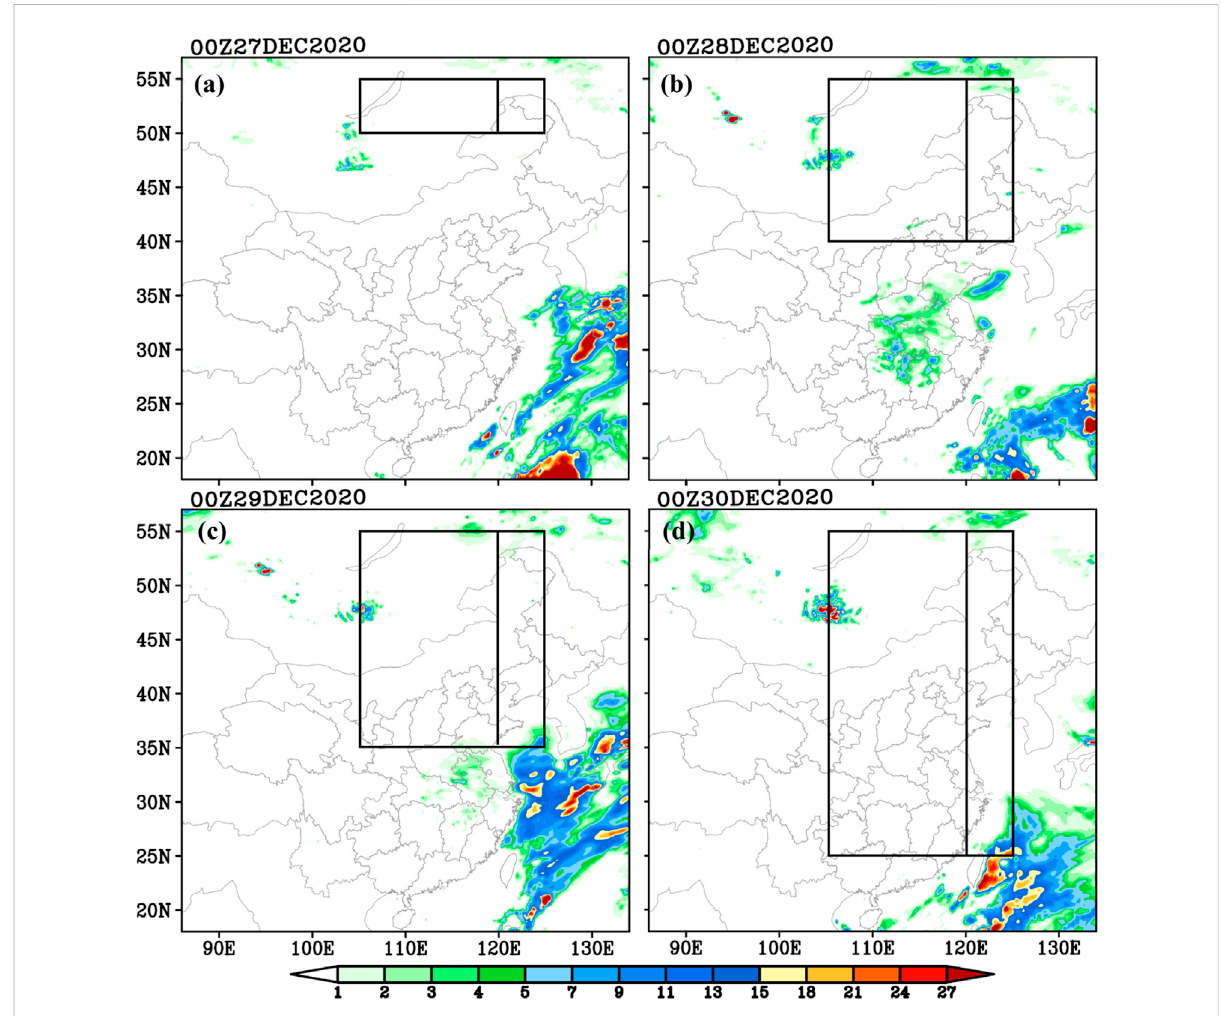
FIGURE 2 24-hour accumulated precipitation (shading; mm) during the cold wave event. Black boxes = FR1 and FR2 of the cold wave